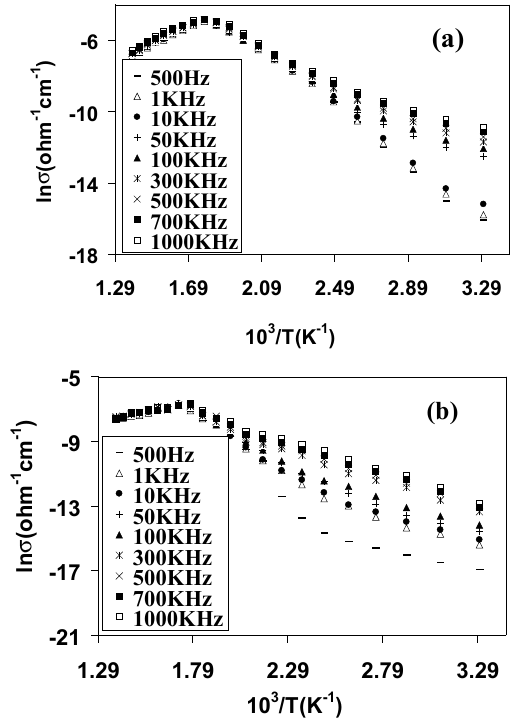
Figure 6. Temperature dependence of ac conductivity as a function of frequency for pure SnO , calcined at 500°C: (a) using 2 sol-gel and (b) direct precipitation